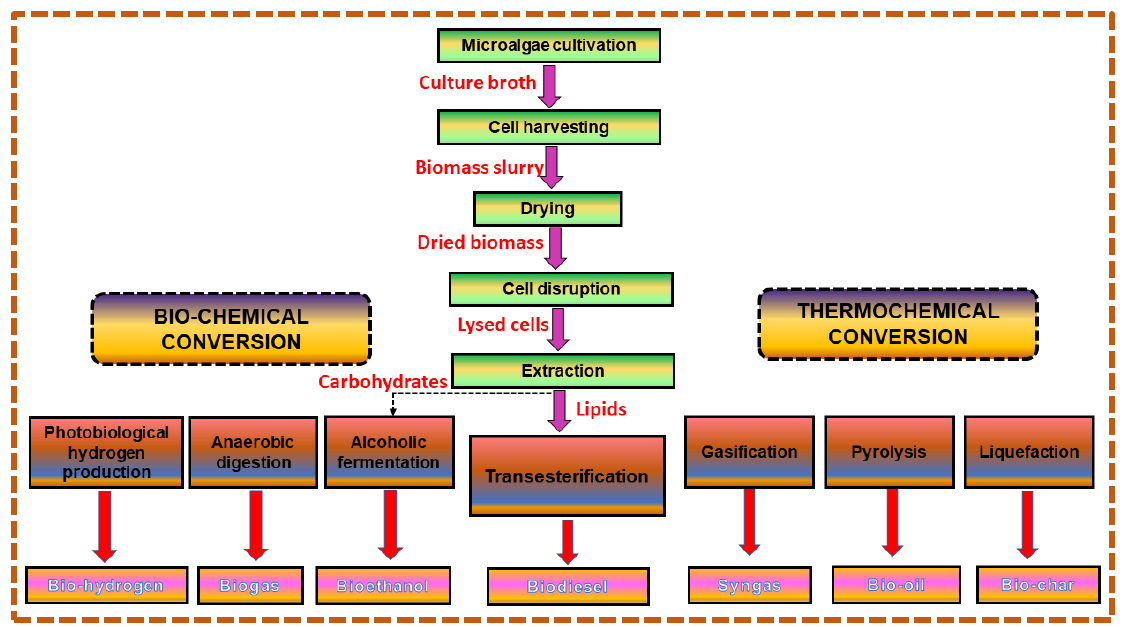
Figure 2. Generation of biofuels from microalgae by employing several conversion techniques. Table 2. Operational modes of different thermochemical conversion techniques